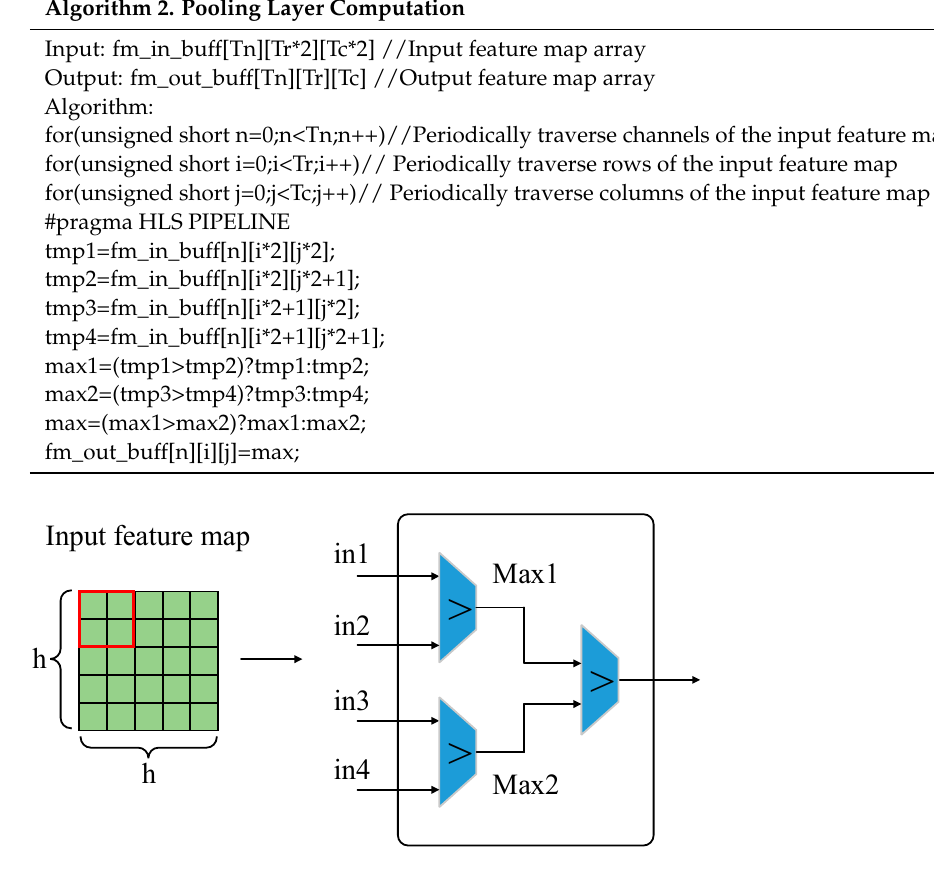
Figure 9. Pooling computation structure. Algorithm 2. Pooling Layer